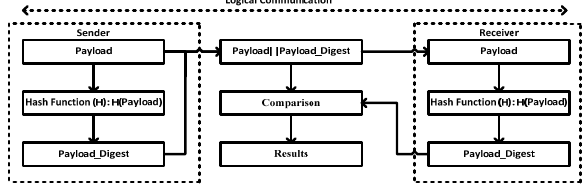
Figure 9. Security development Using hashing function.